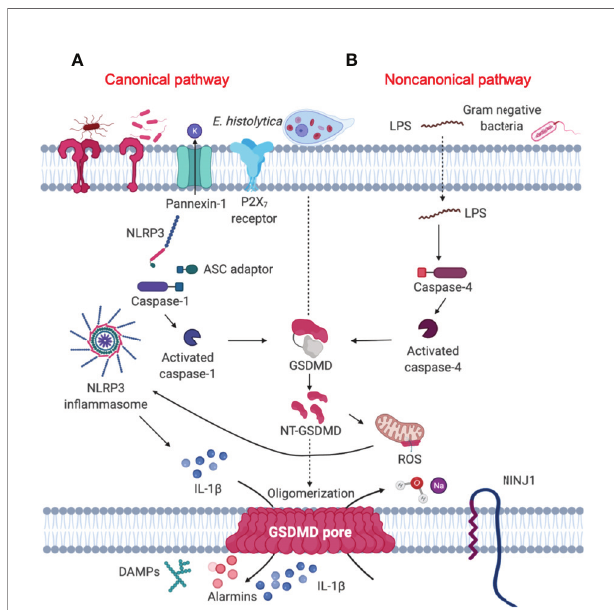
FIGURE 2 | Gasdermin D-mediated pyroptosis is regulated by both canonical and noncanonical signaling pathway. (A) Canonical in fl ammasome pathway (left) constitute a Nod-like receptor (NLRP3), the adaptor protein ASC and pro-caspase-1, which converts pro-IL-1 b into its active form. Activated caspase-1 cleaves GSDMD to unleash the NT- GSDMD, which mediates bioactive IL-1 b release and ultimately causes cell pyroptosis (19). (B) Cytosolic LPS released from Gram-negative bacteria (20) and the extracellular protozoan Eh can trigger the activation of caspase-4 (21), leading to activation of the noncanonical signaling pathway (right). Activated caspase-4 in turn, cleaves GSDMD in a similar fashion as canonical caspase-1 to mediate the secretion of mature pro- in fl ammatory cytokines (22). NINJ1 is a cell-surface protein that contains two transmembrane domains and is a mediator of plasma membrane rupture that can release pro-in fl ammatory cytokines